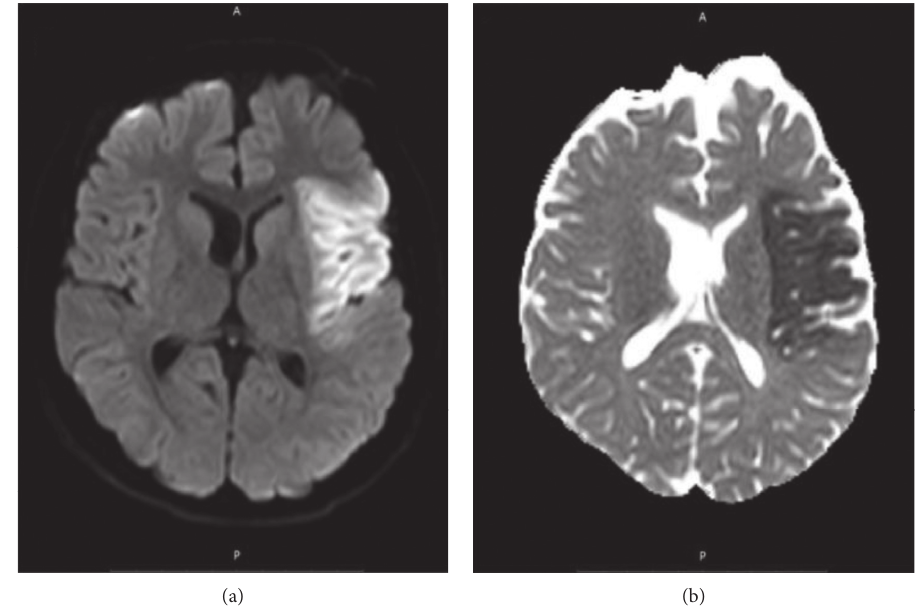
Figure 3: Axial MRI images (a) diffusion weighted and (b) apparent diffusion coefficient (ADC), showing acute brain ischemia in the territory of the medial cerebral